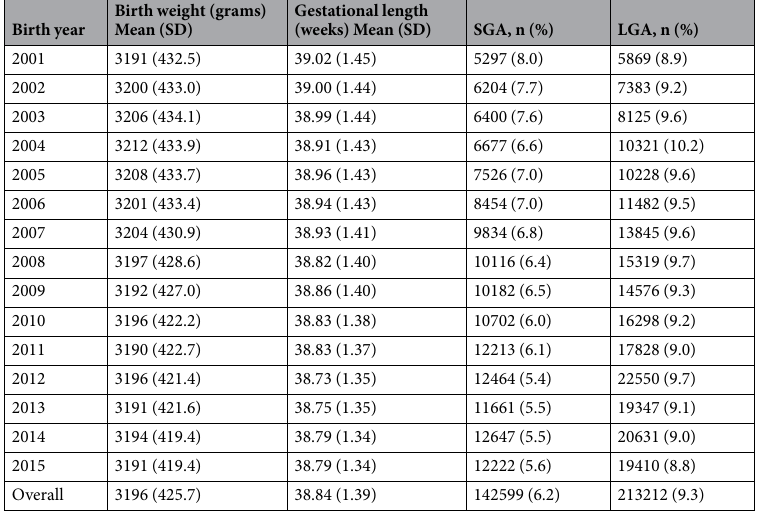
Table 2. Means of birth weight and gestational length and incidence of SGA and LGA during 2001–2015 in Guangzhou. SGA, small for gestational age; LGA, large for gestational age, based on the INTERGROWTH-21st standard.